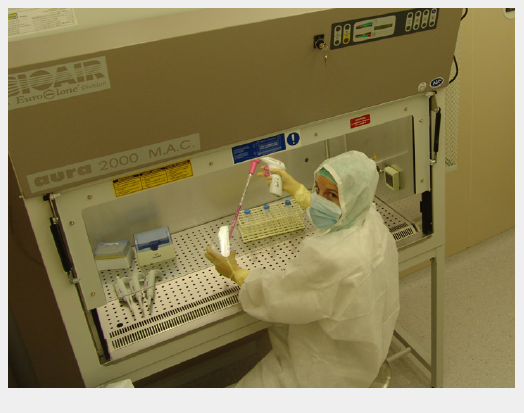
Good Manufacturing Practice (GMP) cell therapy unit at the Cardiocentro Ticino, Lugano. GMP facilities are required for ex vivo expansion of cells used in clinical